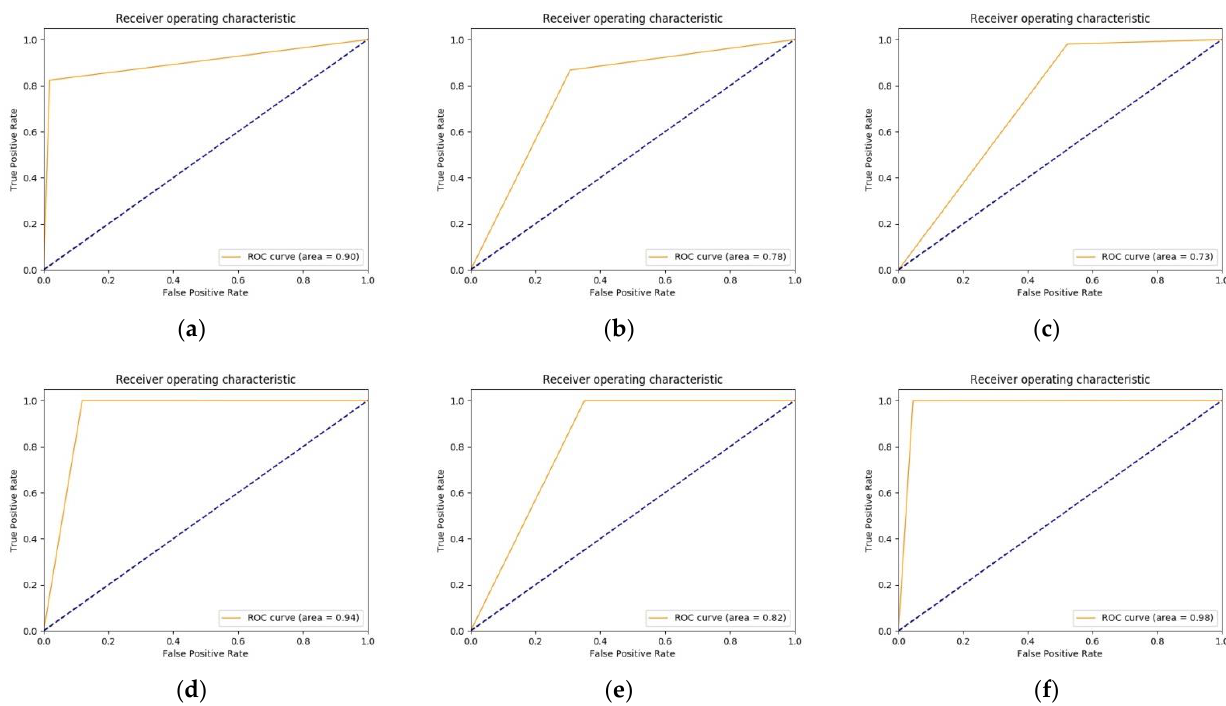
Figure 7. ROC curves for different considered customized models: ( a ) VGG16; ( b ) ResNet50; ( c ) GoogLeNet; ( d ) Inception-v3; ( e ) Inception-v4; and ( f ) IR-v2.